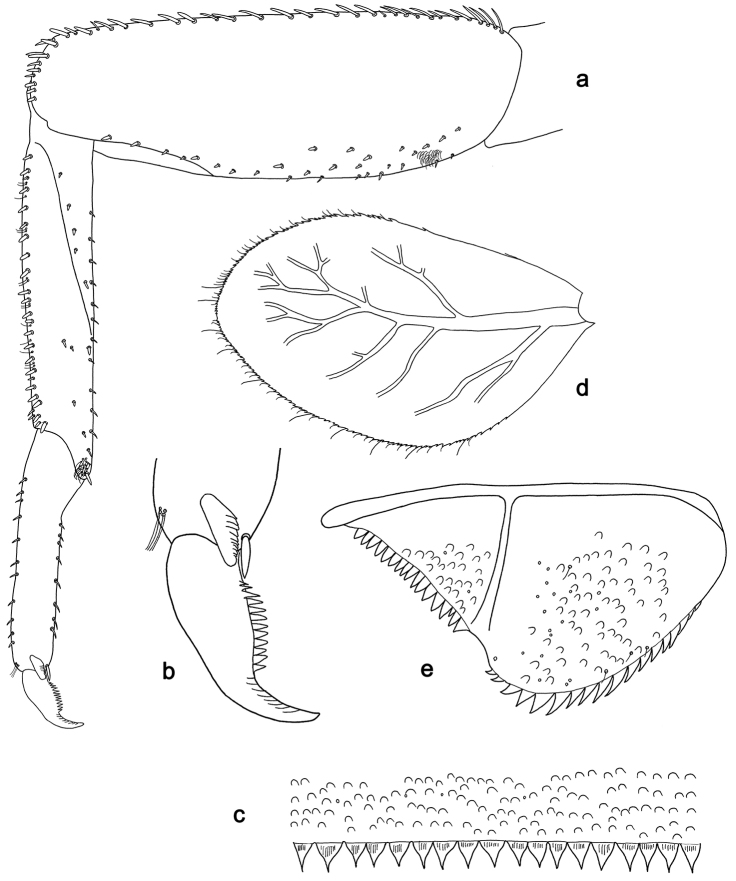
Labiobaetisclaudiae sp. n., larva morphology: aForelegb Fore claw cTergum IV d Gill IV eParaproct.